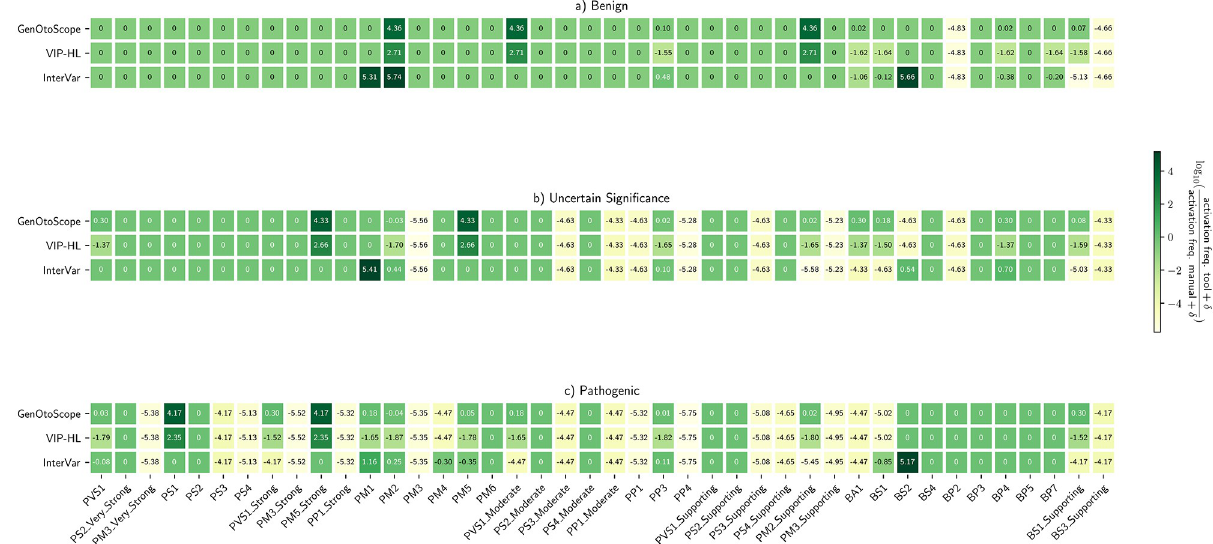
Fig 9. Activation frequency ratios for VCEP-HL data set. Log ratios calculated for each of the three classes classified by the VCEP-HL: (A) “Benign” broader class, (B) “VUS” class and (C) “Pathogenic” broader class.